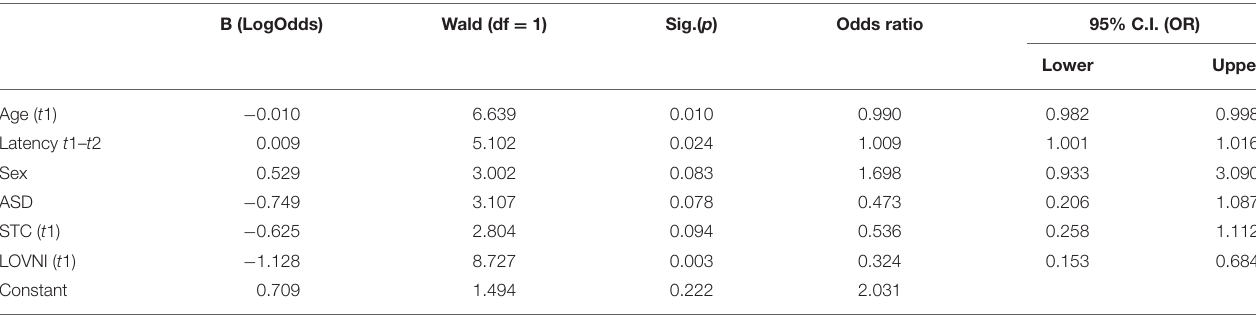
TABLE 5 | Logistic regression model after sequential deletion of non-significant predictors (Alpha =